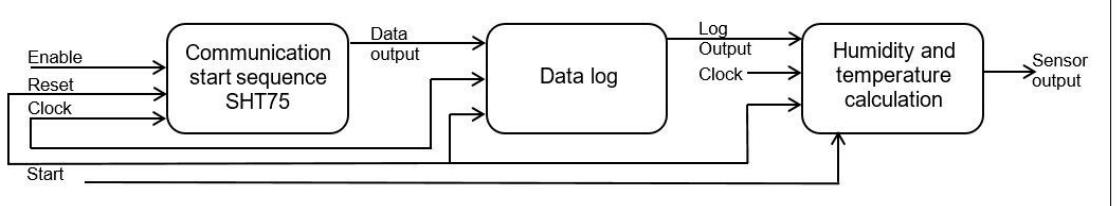
Figure 10. Block diagram of the SHT75 in the FPGA. First, a block was designed in charge of providing the communication start and restart sequence. Subsequently, a state machine, a frequency divider module, and a multiplexer were implemented for the data input and output of the FPGA. Figure 11 results from the measurement process developed with the SHT75